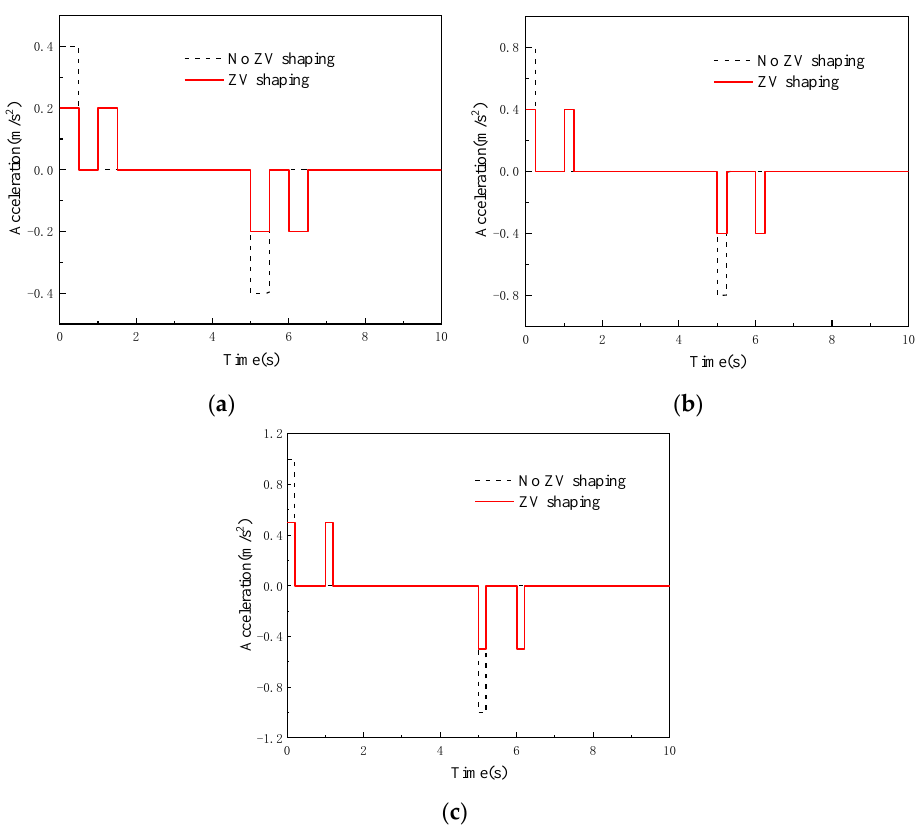
Figure 10. Acceleration curves of the trolley before and after shaping: ( a ) condition 1; ( b ) condition 2; ( c ) condition 3.